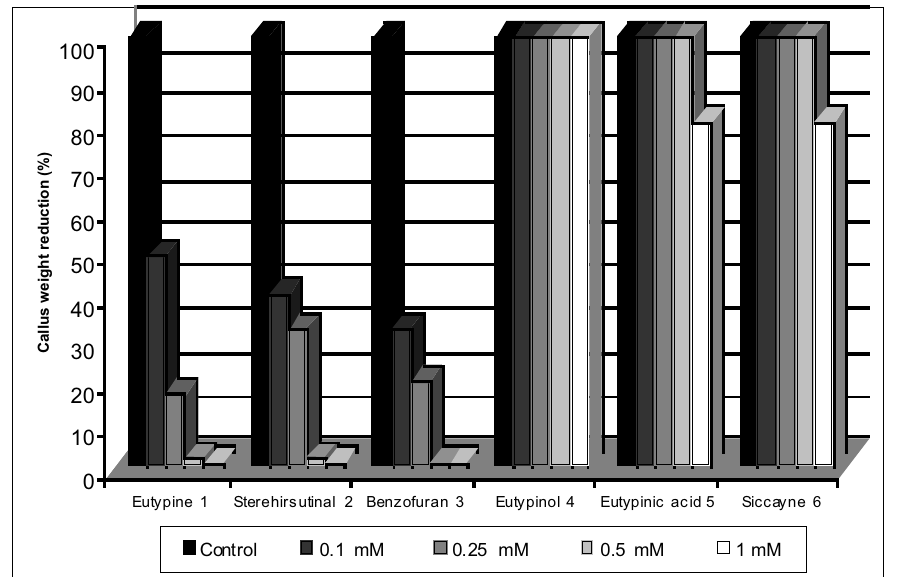
Fig. 4. Growth inhibition of Gamay callus by the synthetic eutypine derivatives compared with eutypine and stere-